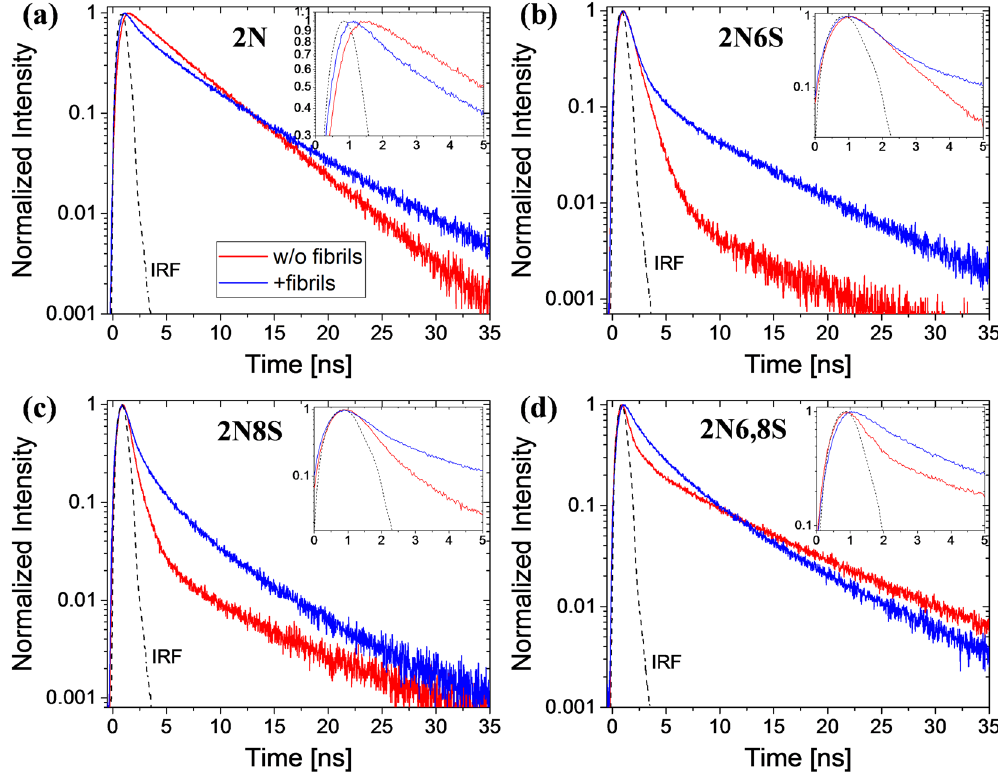
Figure 3. Time-resolved fluorescence of the ROH * band of the different photoacids: ( a ) 2N, ( b ) 2N6S, ( c ) 2N8S and ( d ) 2N6,8S, in pH7 buffer (red curves), and in the same buffer with insulin fibrils (blue curves), together with the instrument response function (IRF, dashed black curves). The graphs are on a semi-logarithmic scale and the insets show a magnification of the first 5 ns. The linear scale representation is in Figure